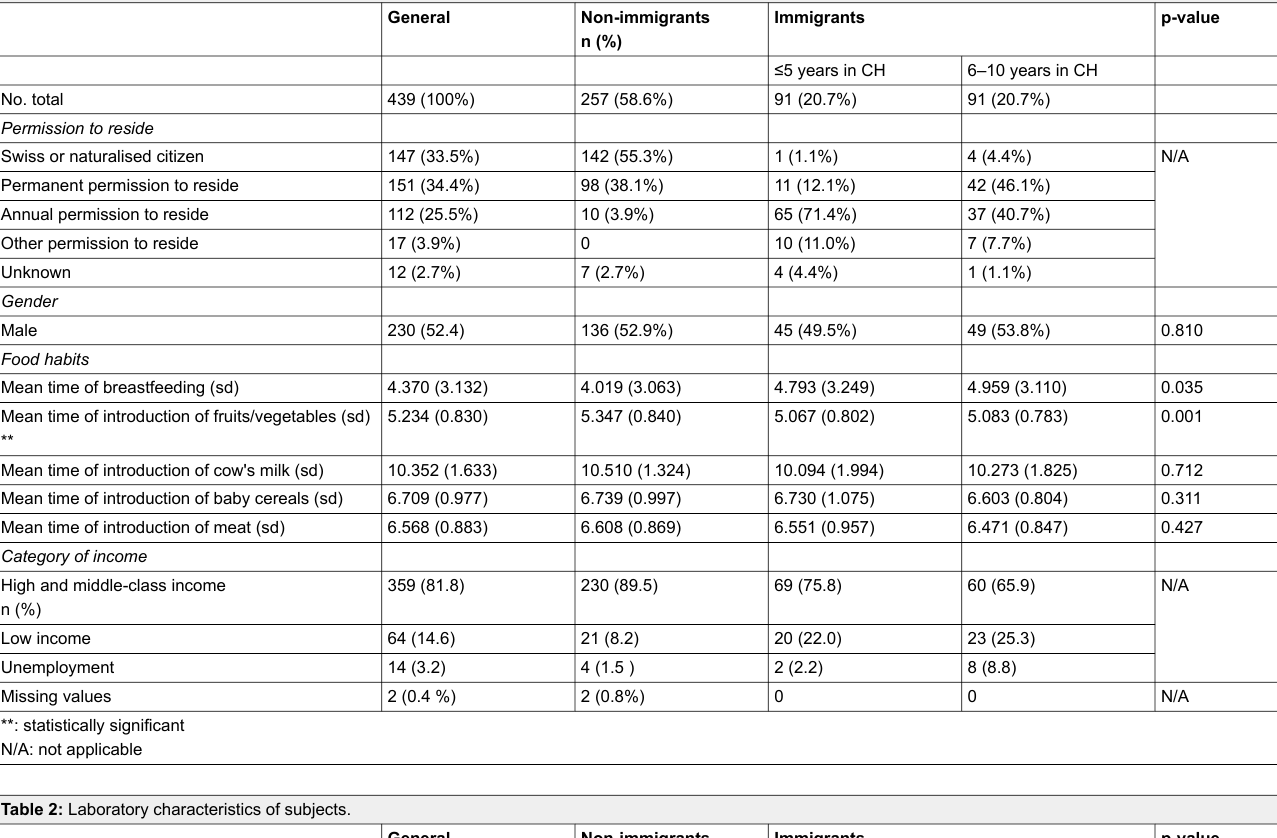
Table 1: Patient demographics.